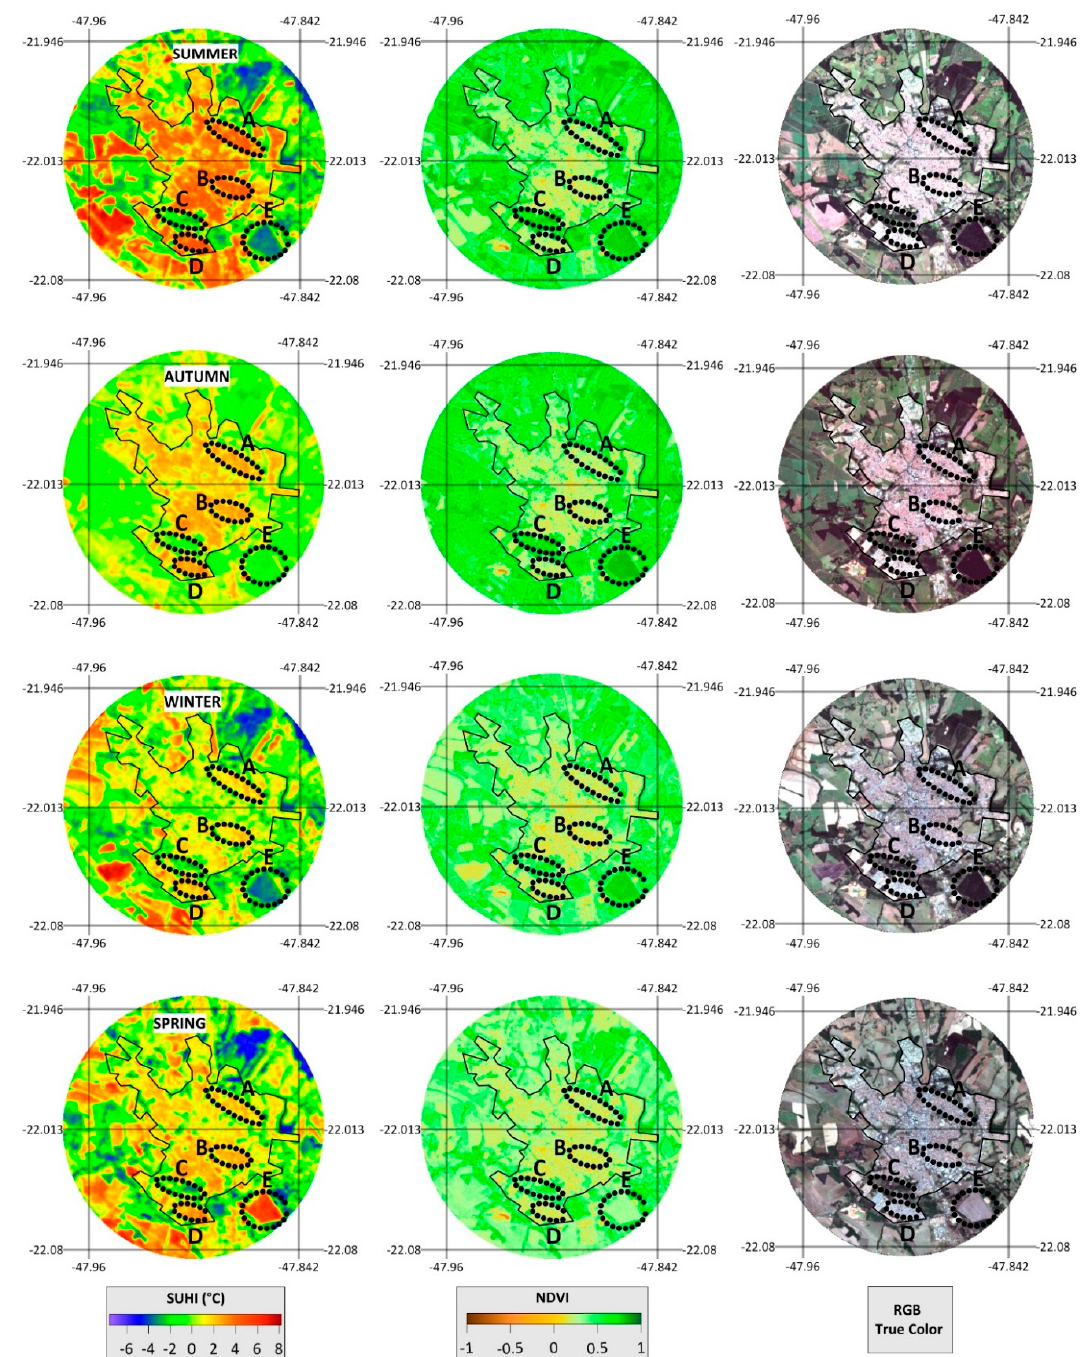
Figure 6. Urban surface heat islands, NDVI and RGB (Red, Green, Blue) images obtained in the summer, autumn, winter and spring. The sites A, B, C, D and E, represented by dashed ellipses, refer to areas that show different patterns in SUHI and NDVI intensity.